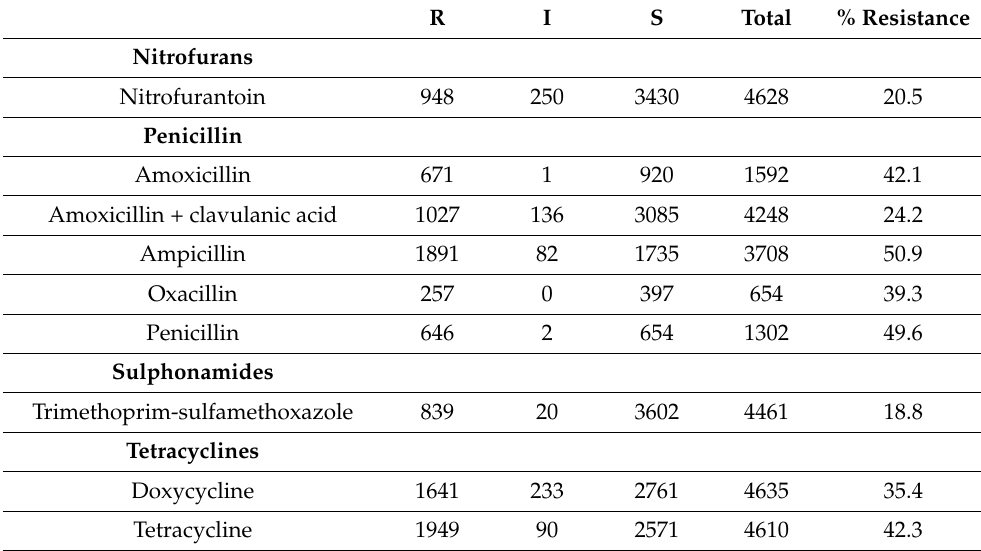
Table 3. The pattern of antimicrobial sensibility in the 5306 isolates between 2017 and 2021 (R—resistant, I—I-intermediate, S—sensible) to nitrofurans, penicillin, sulphonamides, and